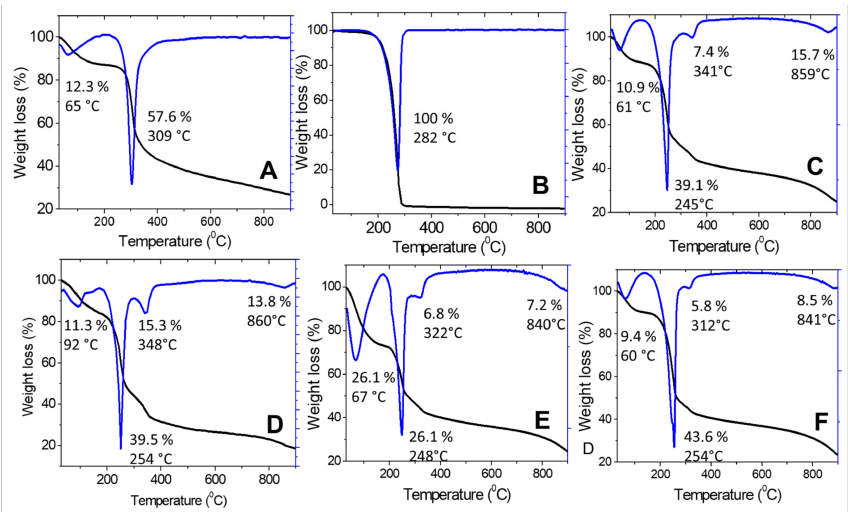
Figure 3. TGA / DTG thermograms of ( A ) CEN, ( B ) pure hexaconazole and chitosan–hexaconazole nanoparticles prepared at various concentrations of TPP, ( C ) 2.5, ( D ) 5, (E) 10, and ( F ) 20 mg /